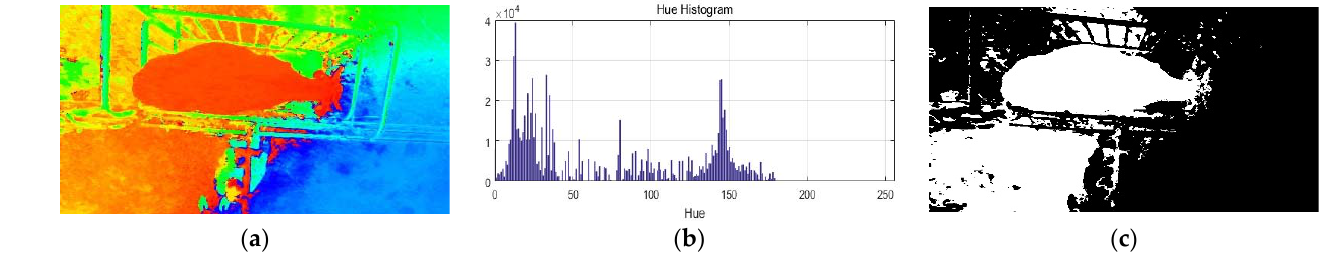
Figure 4. Segmentation process of cattle from RGB image: ( a ) Hue component of cattle; ( b ) histogram of Hue image; ( c ) segmentation result of cattle.